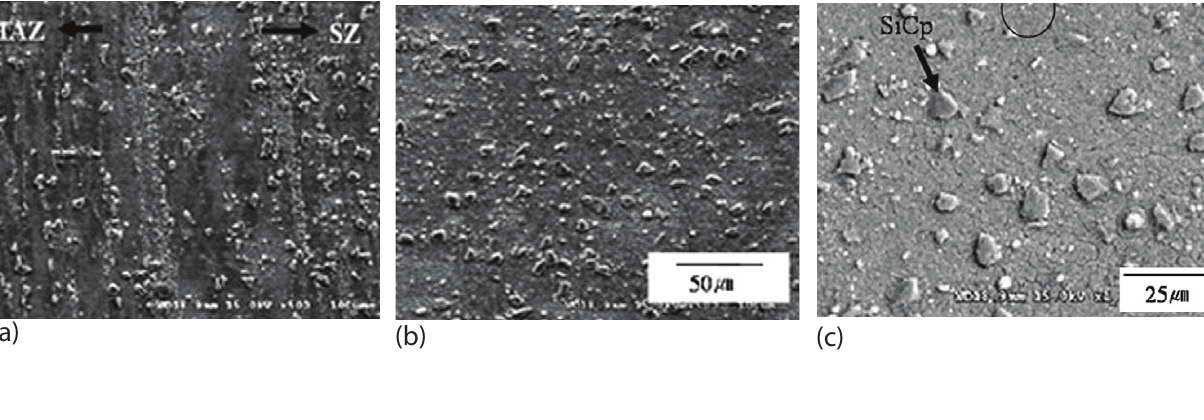
Figure 10 . Microstructure of SiC particle reinforced AZ91 magnesium alloy composite material (after Lee et al. [69]): (a) the area showing the transition from thermomechanical affected zone (TMAZ) to stir zone (SZ); (b) uniformly distributed SiC particles in the stir zone; (c) higher magnification image of stir zone showing the SiC particles on the etched surface of the composite.